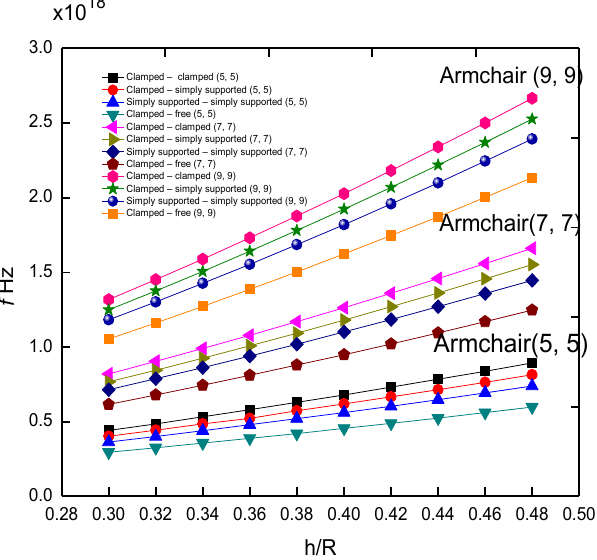
Figure 5. Variation of fundamental frequencies (Hz) with tube thickness-to-radius ratio h/R for armchairs (5, 5), (7, 7), (9, 9), L = 2 . 4nm for different boundary